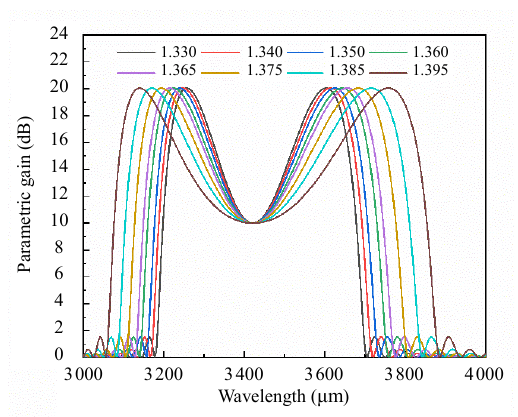
Fig. 7 When RI changes from 1.33 to 1.395, the FWM spectra change at 3 420 nm.